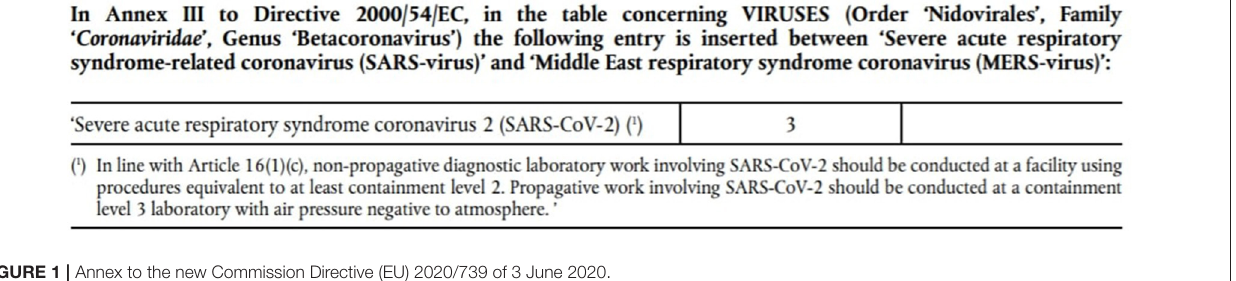
preventive discipline for the protection of health and safety at work provided for by Legislative Decree no.